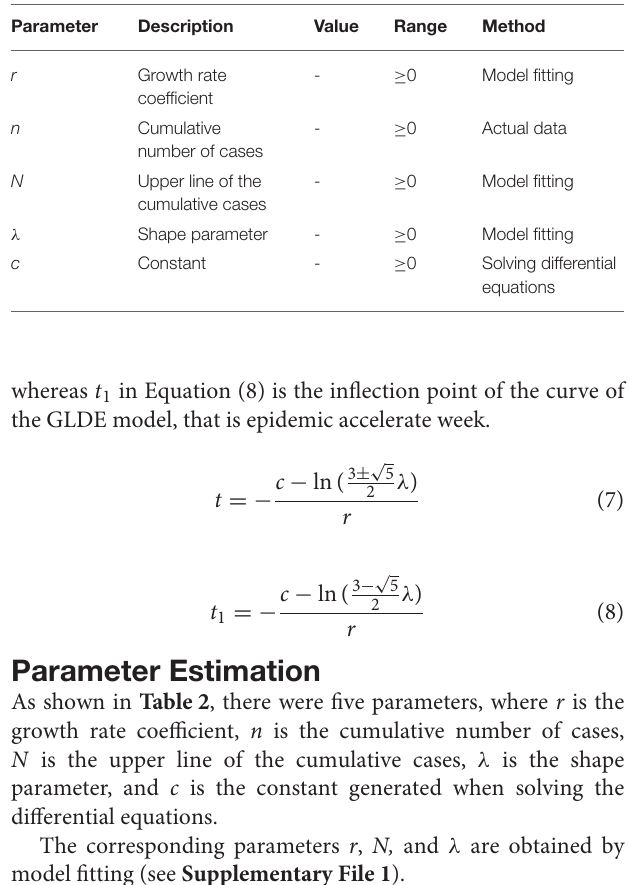
TABLE 2 | Definitions and sources of model